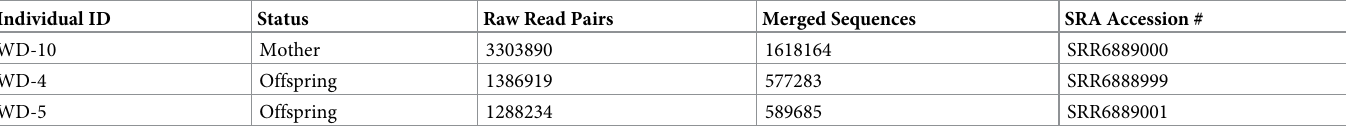
Table 2. Total number of raw and merged reads per individual. Merged reads were used in the analyses to identify microsatellites. Raw reads were accessioned in the NCBI Sequence Read Archive (SRA).